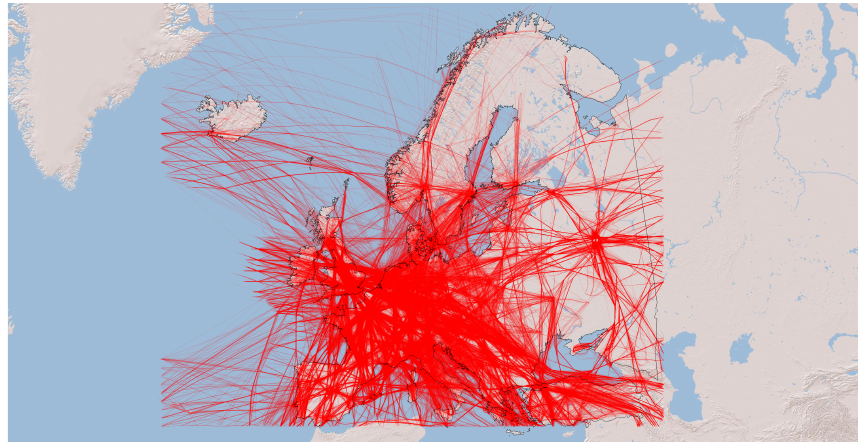
Figure 1. Visualization of all flight trajectories from the dataset (map tiles by ESRI, ArcGIS licensed